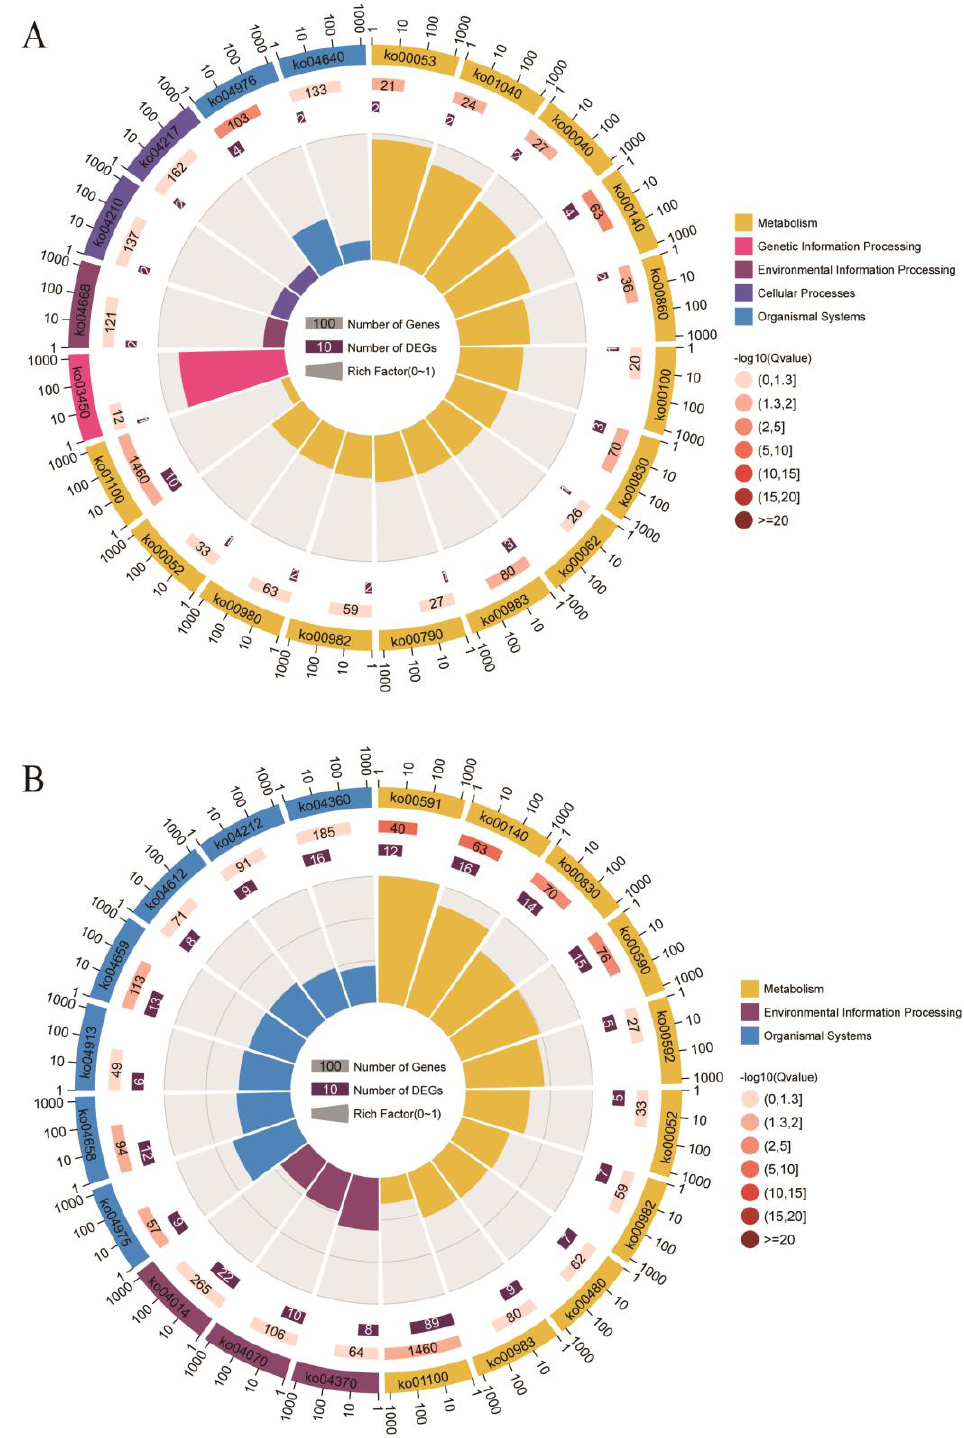
Figure 6. KEGG pathway enrichment of group−differential CNVRs. ( A , B ) represent KEGG pathways of the top 1 and top 10 group−differential CNVRs, respectively. The circles represent the pathway ID, number of background genes, and number of group−differential CNVRs overlapping genes from outside to inside. The number outside the circle represents the quantity co−ordinate. Length of bars represents the rich factor of the relative pathway.